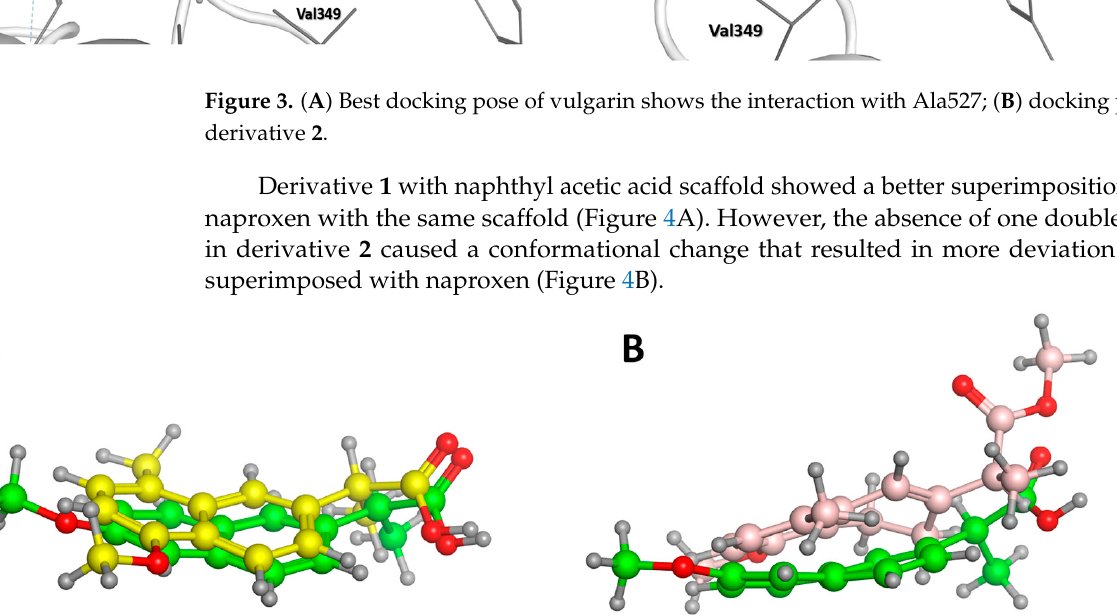
Figure 4. ( A ) Superimposition of naproxen (green) with derivative 1 (yellow); ( B ) superimposition of naproxen (green) with derivative 2 (pink).